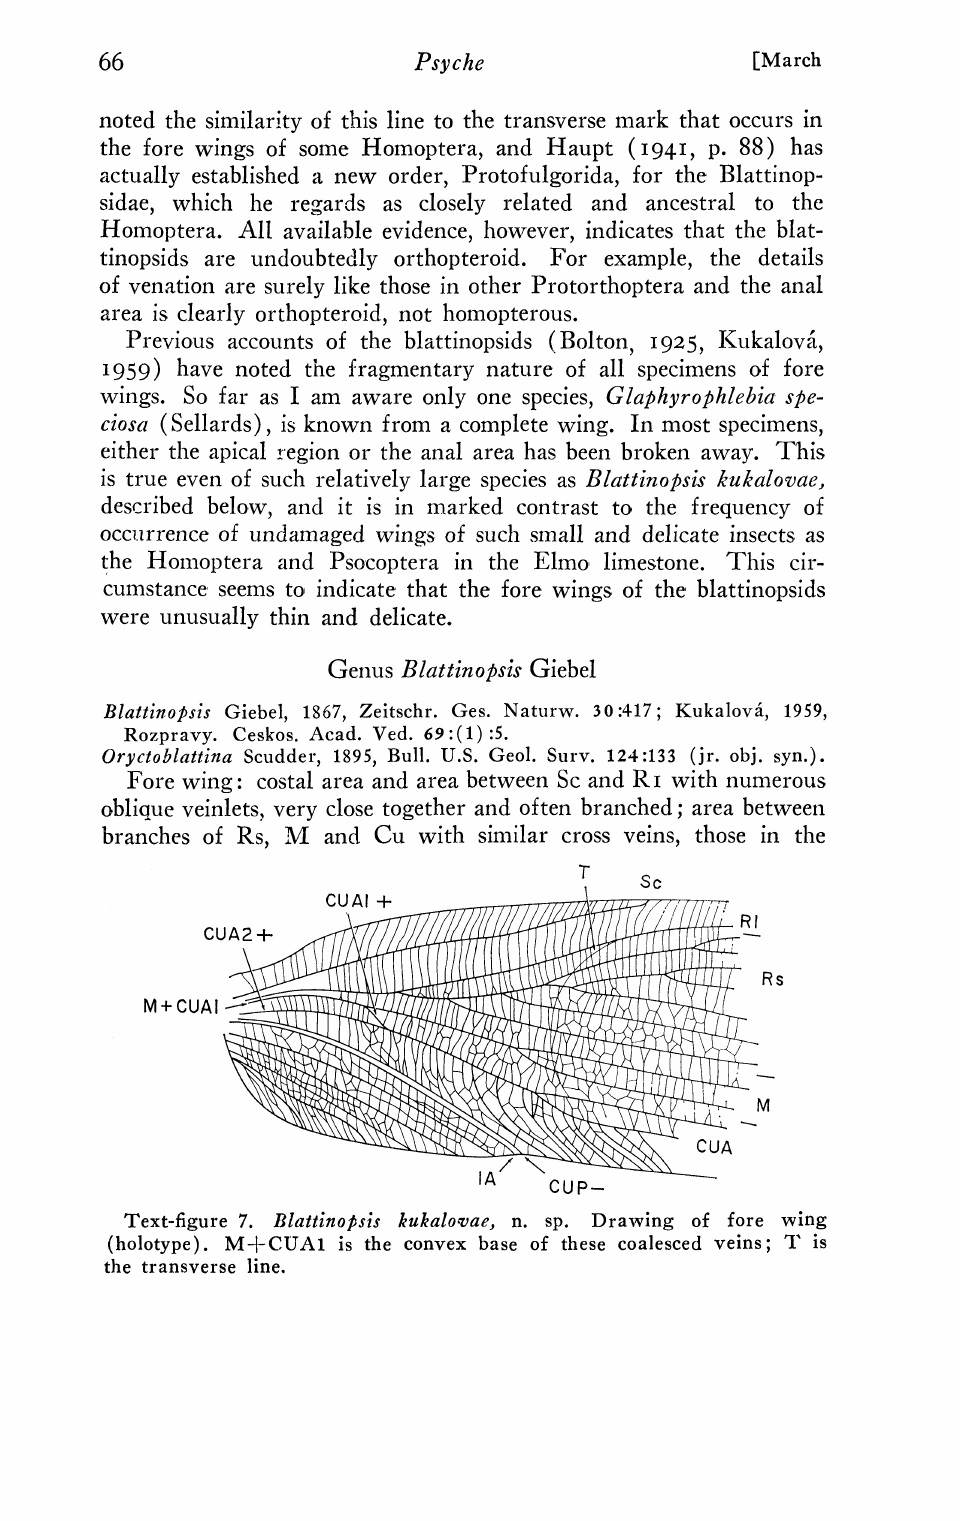
Text-figure 7. Blattinopsis kukaloae, n. sp. Drawing o{ fore wing (holotype). M+CUA1 is the eonvex base of these eoaleseed veins; T is the transverse